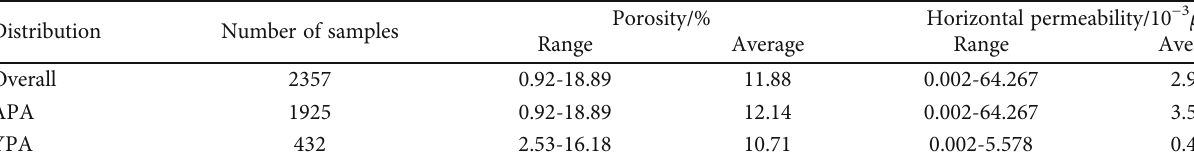
Table 4: Physical property parameters of the core analysis (according to [47]).